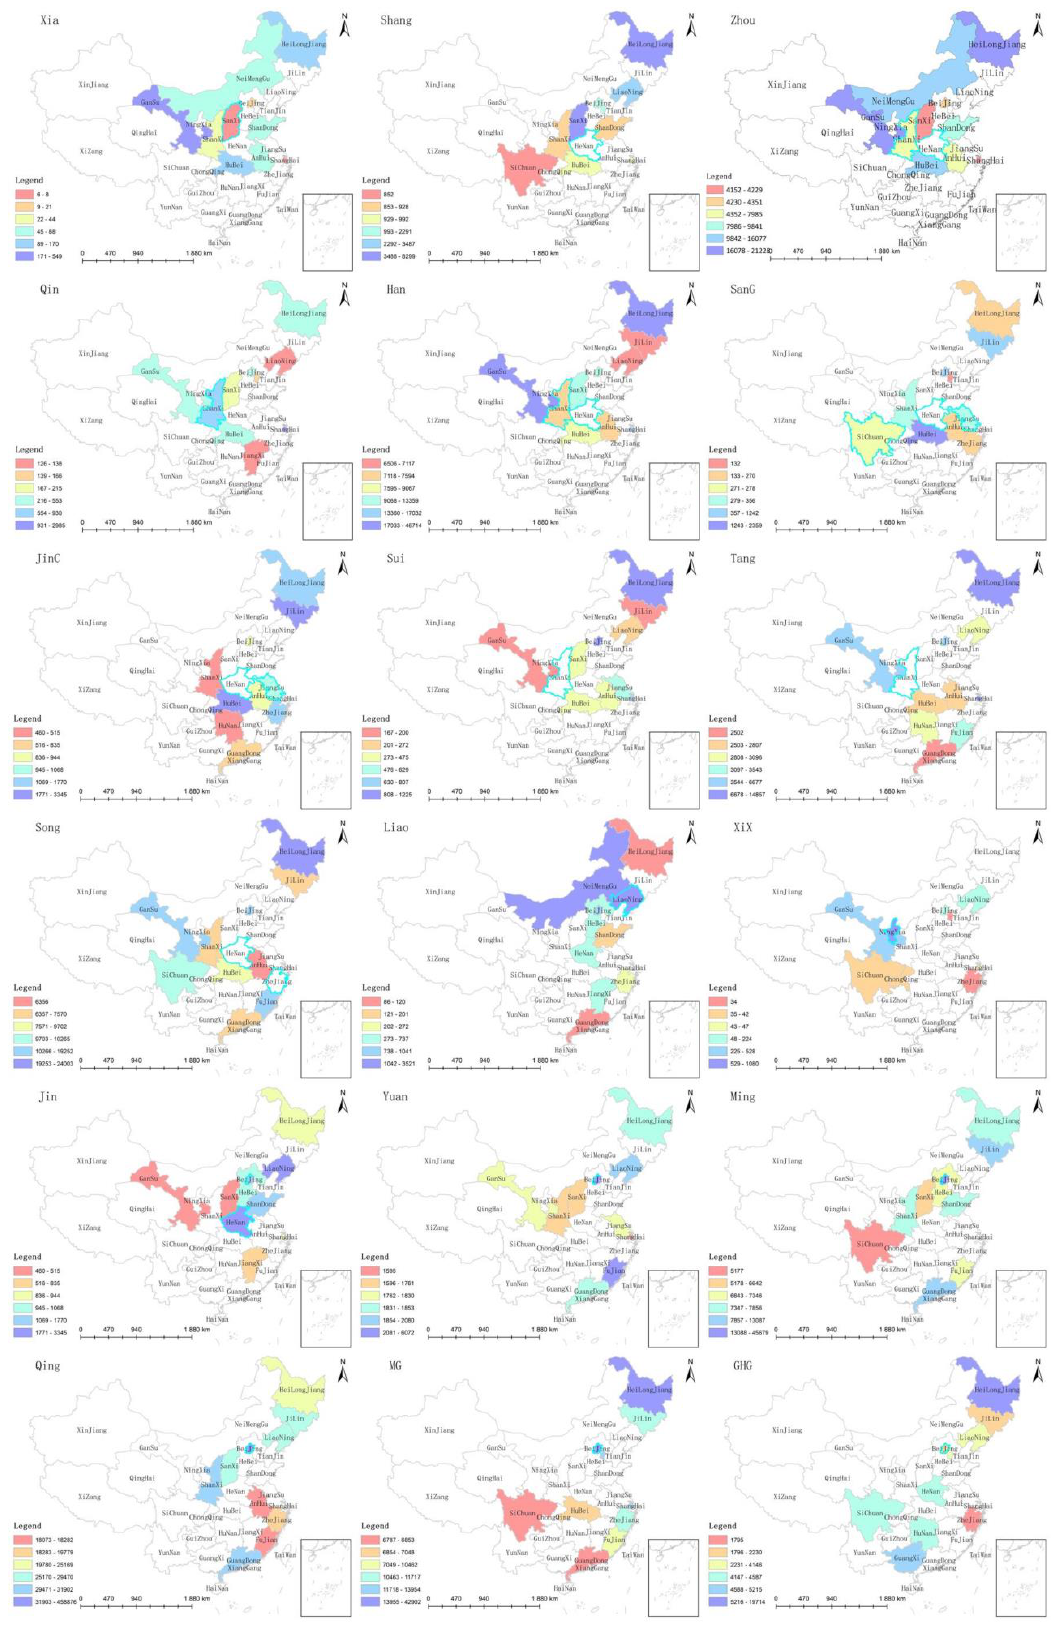
Figure 6. Geographical adjacency